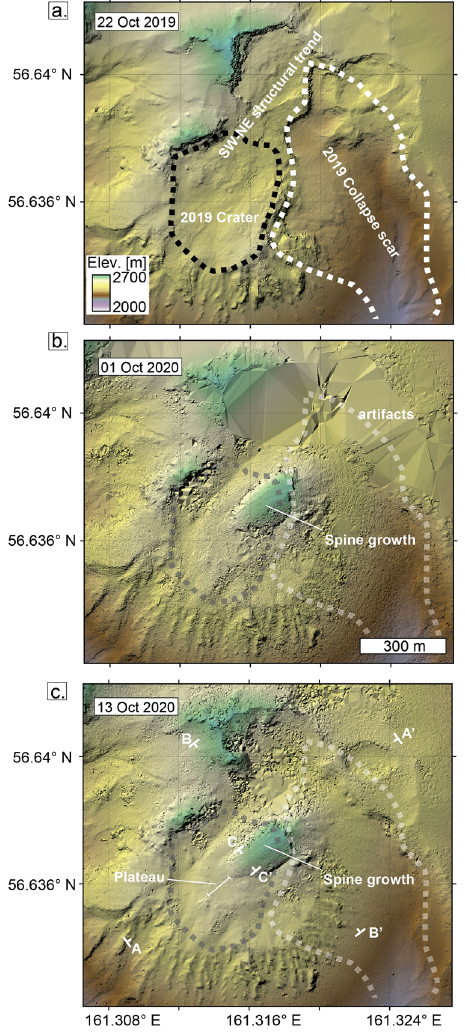
Fig. 4 Digital terrain models (DTM) produced from stereo imagery. a A DTM on October 22, 2019 (before the spine growth) reveals the presence of a number of summit craters roughly aligned along the SW-NE structural trend de fi ned in ref. 33 . Note the deep collapse scar that formed in 2019 on the eastern part of the edi fi ce. b DTM on October 01, 2020, shows the presence of a spine, partly over fl owing the 2019 collapse scar. c DTM on October 13, 2020, shows continuous spine growth, yet cloud artifacts in the northeast. Section locations shown in c . Map created using ArcMap vs.